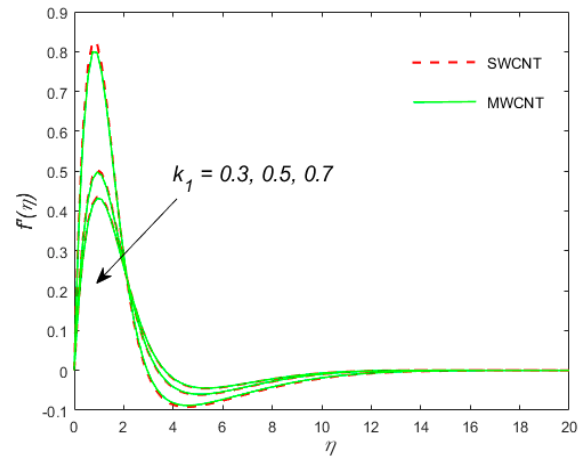
Figure 6. The variation of the velocity distribution profile f’ ( η ) for the case of SWCNT and MWCNT versus the similarity variable for the distinct values of the bio-convection Rayleigh number ( R b ).